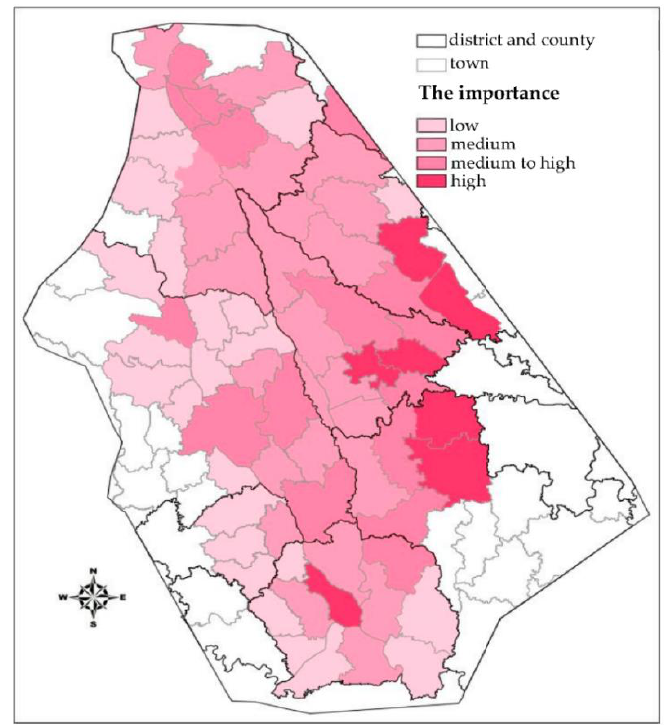
Figure 10. Importance level of each unit.